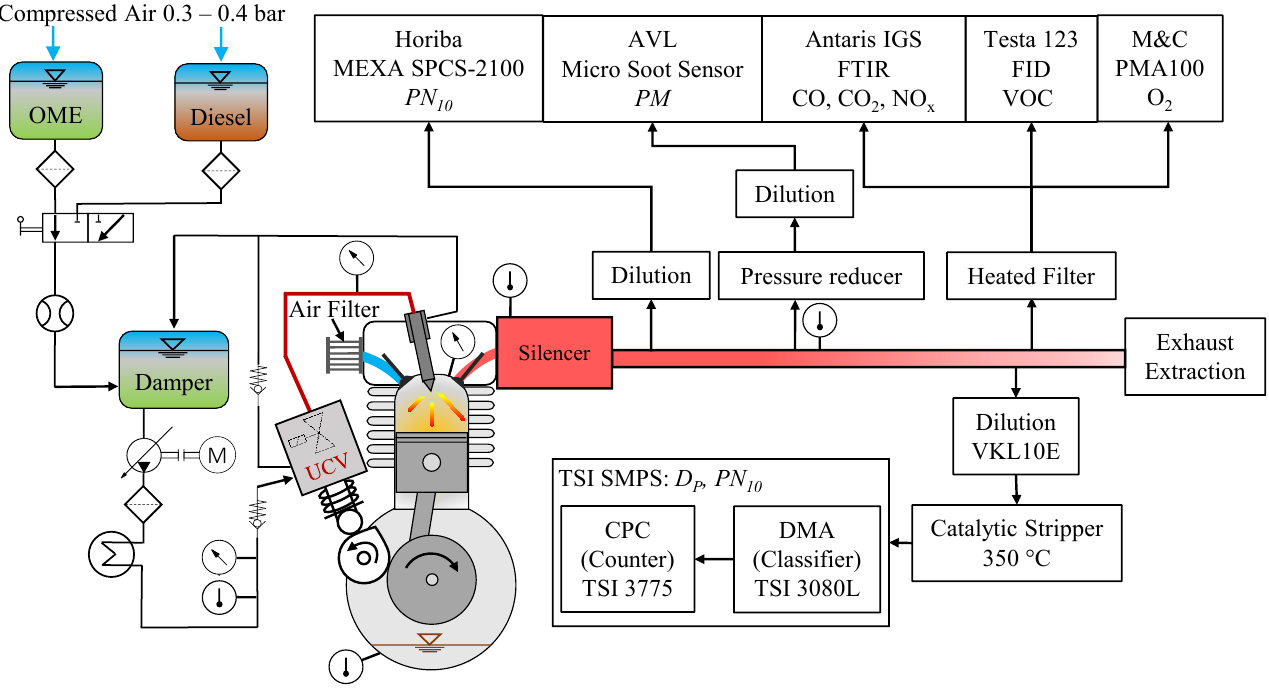
Figure 1. Schematic layout of the fuel system and the engine test bench with all measurement systems. The two fuel tanks are pressurized with compressed air at a constant pressure of 0.35 bar, and the outflowing fuel is then pre-filtered. After a changeover valve, the fuel flows through a coriolis flow meter (Section 2.2.3) into a compensating volume. The compensating volume is partially filled with air and serves to dampen pulsations in the low-pressure circuit. The pre-feed pump regulates the fuel pressure upstream of the high- pressure pump (HPP) to a pressure of 0.5 bar, and the fuel is then filtered and conditioned in a heat exchanger to a temperature of 35 ◦ C. Two check valves prevent back-flow of the